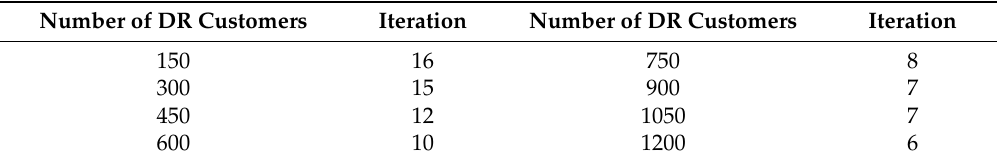
Table 1. Iteration in the game process vs. number of DR customers.